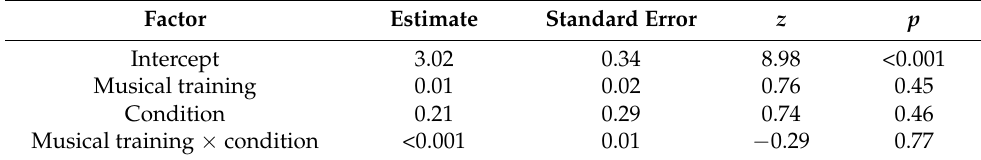
Table 5. Estimates for mixed model on n-2 repetition costs (dependent variable: error